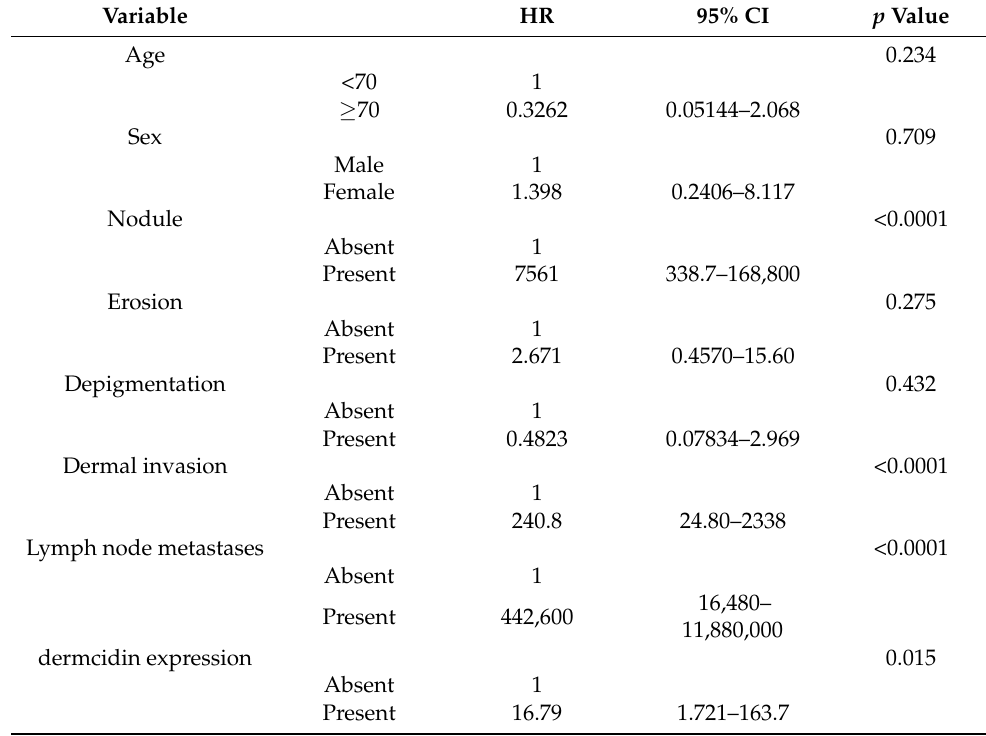
Figure 3. Differences in overall survival curve with or without dermcidin expression in extramam- mary Paget’s disease. The overall survival curves were drawn using the Kaplan–Meier method and were compared with the log-rank test. Table 3. Univariate analysis of clinical